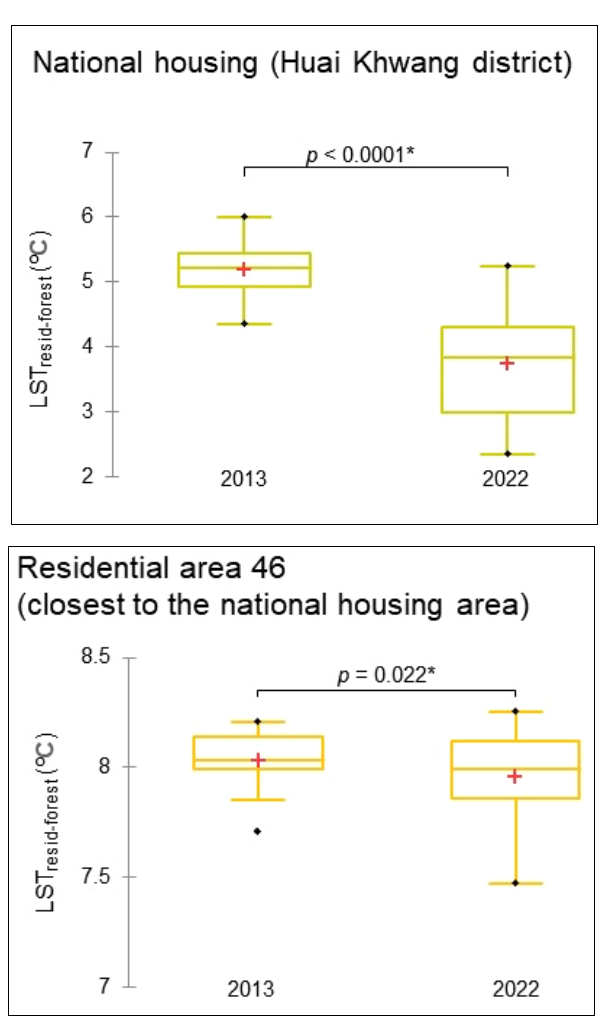
Figure 8. Results of the paired t -test to examine the significant difference in LST resid-forest (°C) between 2013 and 2022. The buildings in the area of the national housing project in Huai Khwan district underwent roof treatment in 2014. The bottom diagram indicates changes in LST resid-forest (°C) in residential area 46. The top and bottom of the box indicates the 25 and 75 percentile values, respectively. The red cross indicates the mean. The black dot indicates an